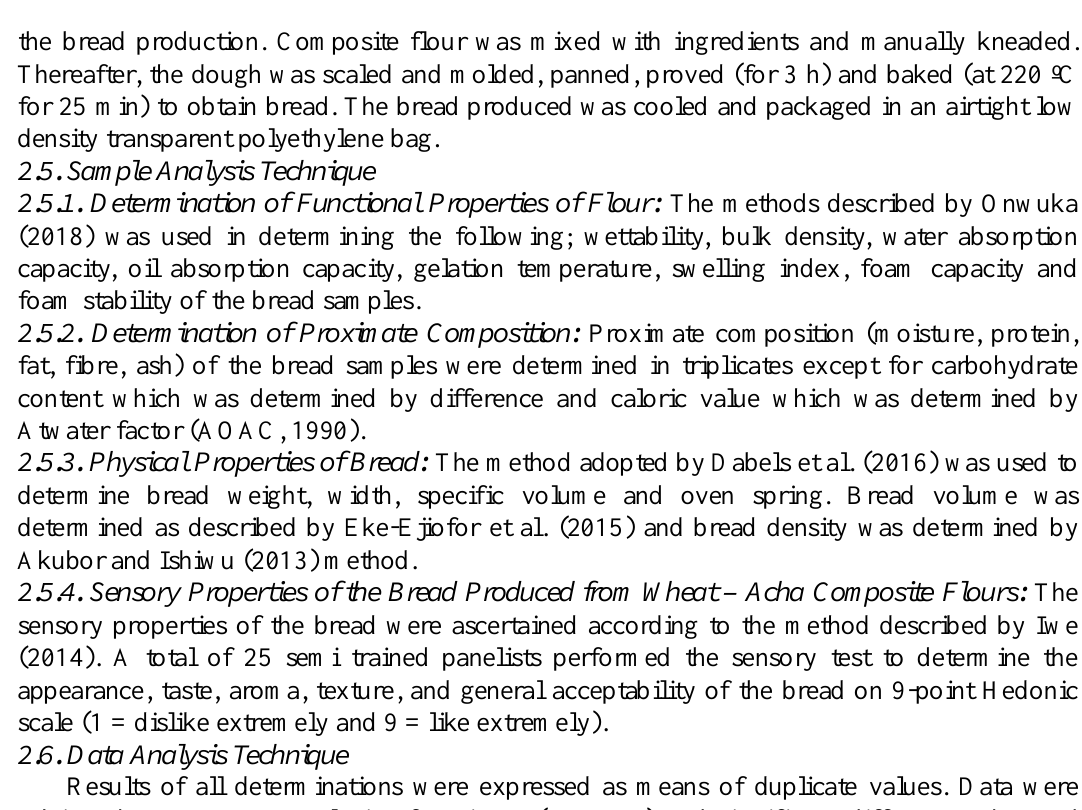
Table 1: Functional Properties of Flour Blends of Wheat and Acha